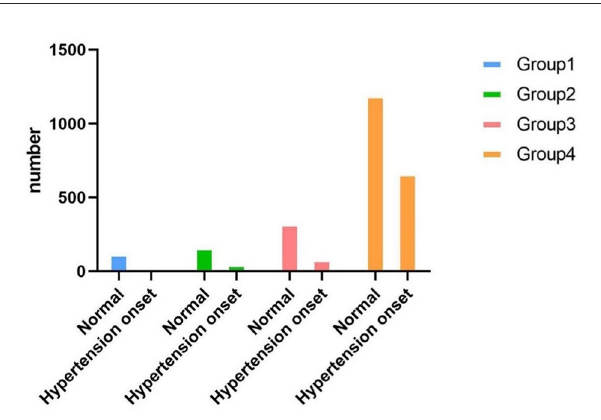
FIGURE3 Bar plot shows the crude prevalence of hypertension onset situation in four groups.